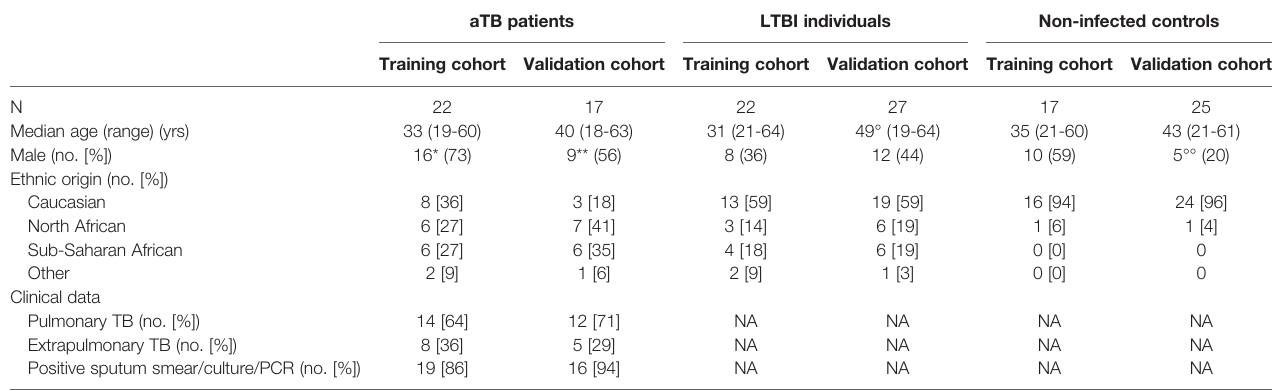
TABLE 1 | Demographic and clinical data from the training and validation